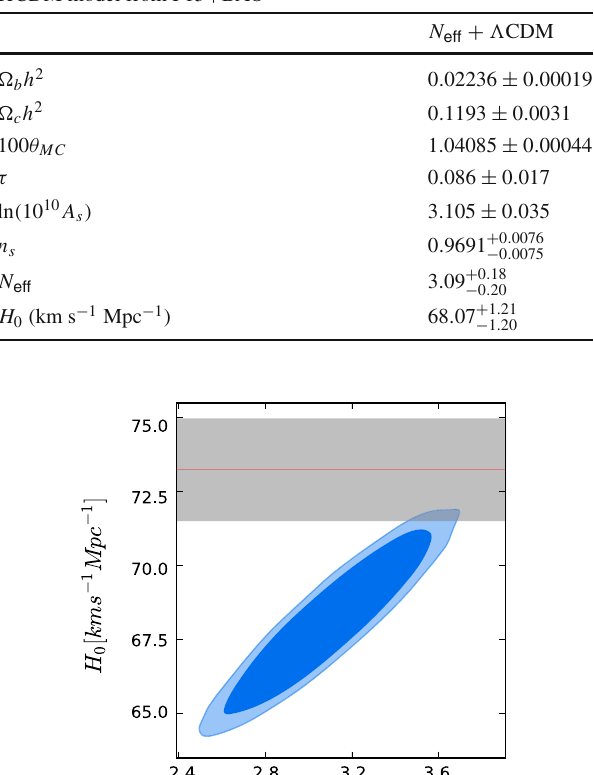
Table 3 The 68% limits for the cosmological parameters in the N eff + (cid:2) CDM model from P15 + BAO